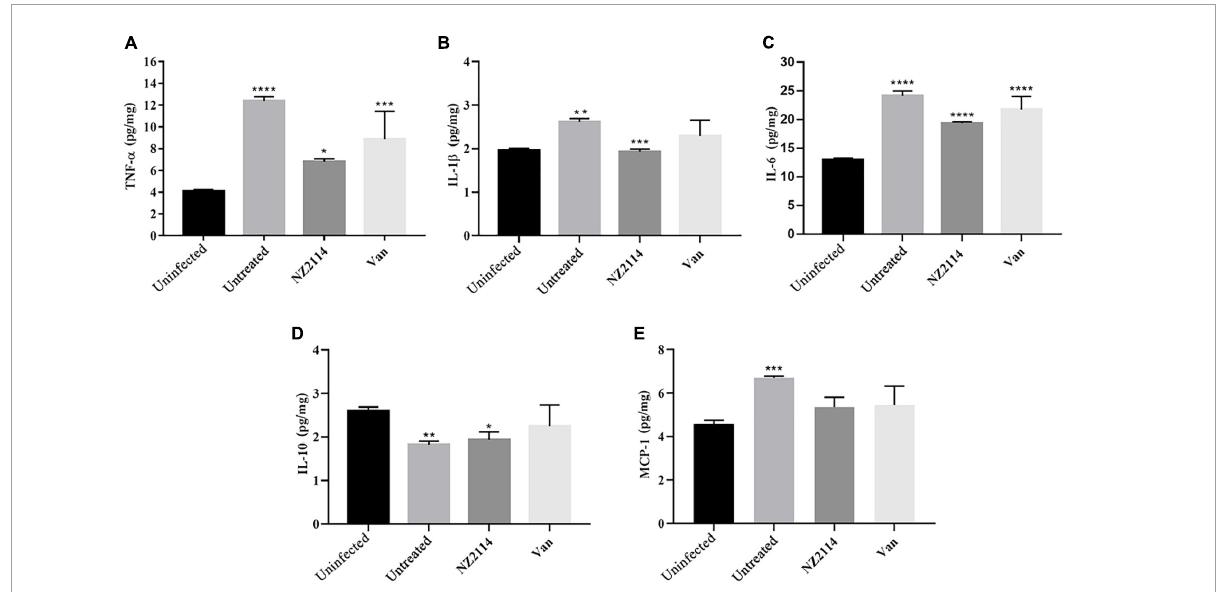
FIGURE6 The protective effect of NZ2114 on the mammary gland of mice at the immune level. Mammary tissues were collected and the levels of (A) TNF- α , (B) IL-1 β , (C) IL-6, (D) IL-10, and (E) MCP-1 were detected by using an ELISA kit after 24 h treatment, respectively. All assays were performed in triplicate. The analyses were measured by one-way ANOVA, with Duncan’s multiple comparisons test. A probability value of < 0.05 was considered significant. (*) Indicates the significance between control and each of treatment groups. ** p < 0.01; *** p < 0.001; **** p < 0.0001. The results are given as the means ± SDs ( n =